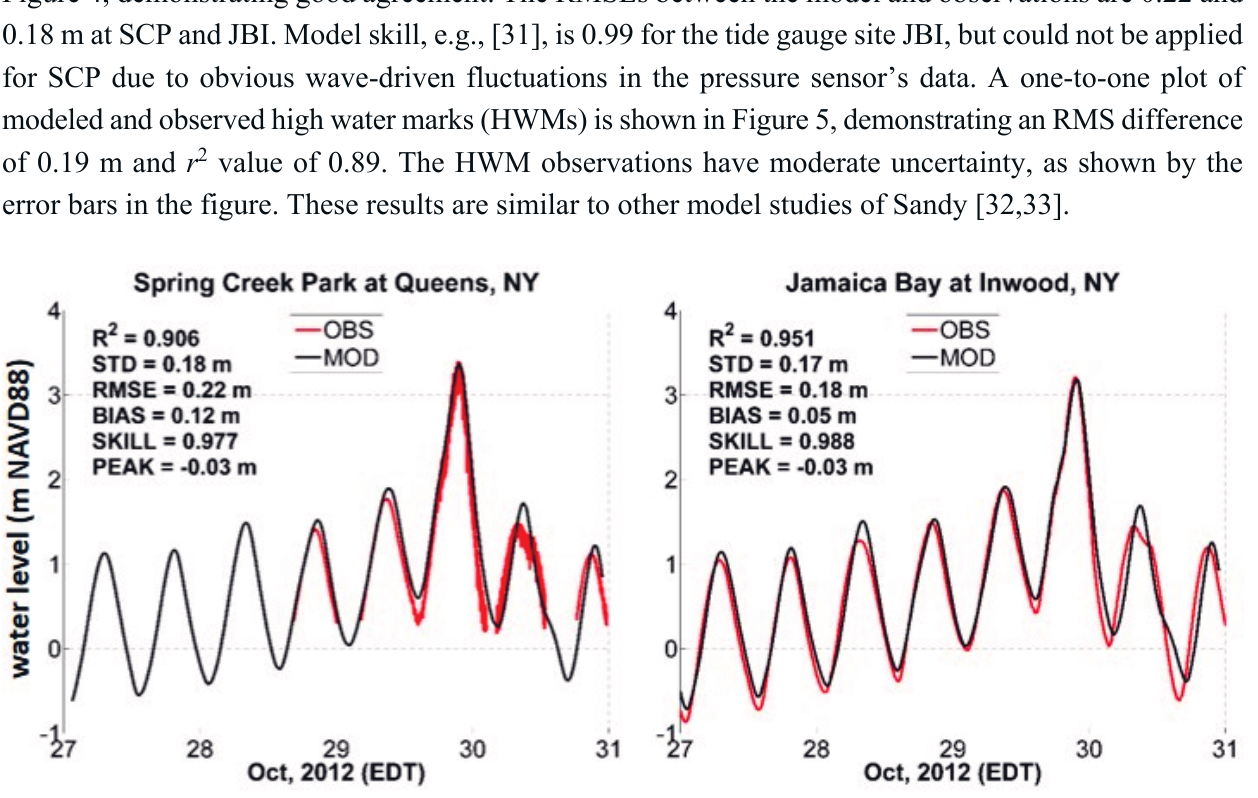
Figure 4. Hurricane Sandy model validation in Jamaica Bay, at ( left ) Spring Creek Park and ( right ) the Inwood tide gauge. Station locations are shown in the first panel of Figure